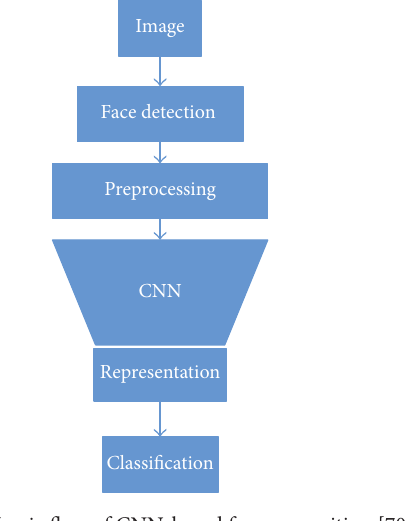
Figure 7: Logic flow of CNN-based face recognition [70]. Table 1: Experiment results on LFW benchmark